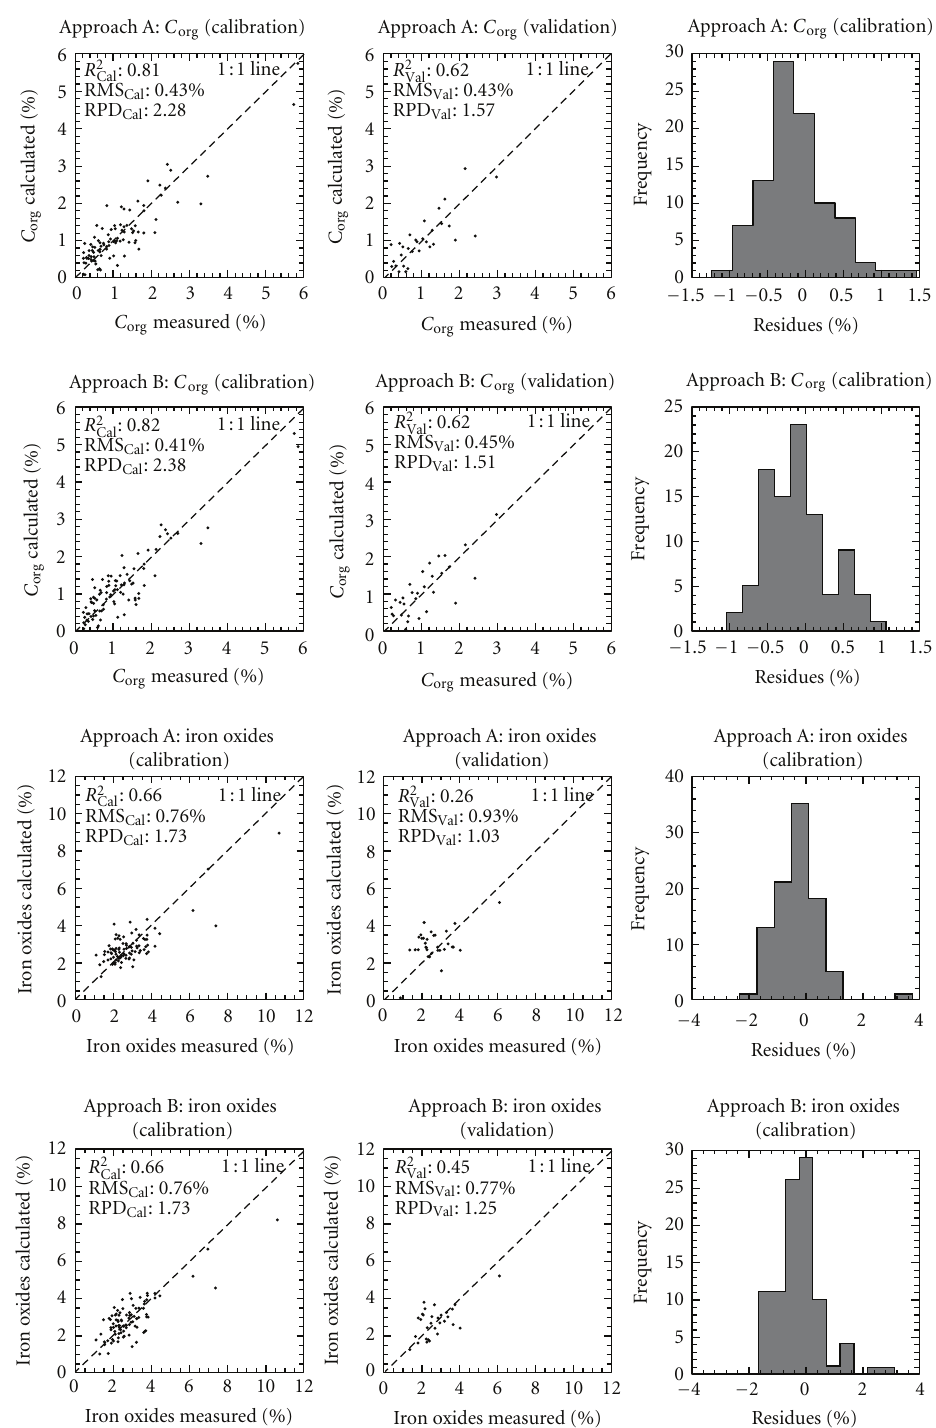
Figure 8: Correlation plots and histograms of calibration residues for the prediction of soil organic carbon and iron oxides using the two presented modeling approaches and developed based on bare soil field spectra in HyMap’s spectral resolution of 116 bands. Approach A: multiple linear regression of spectral parameters, approach B: partial least squares